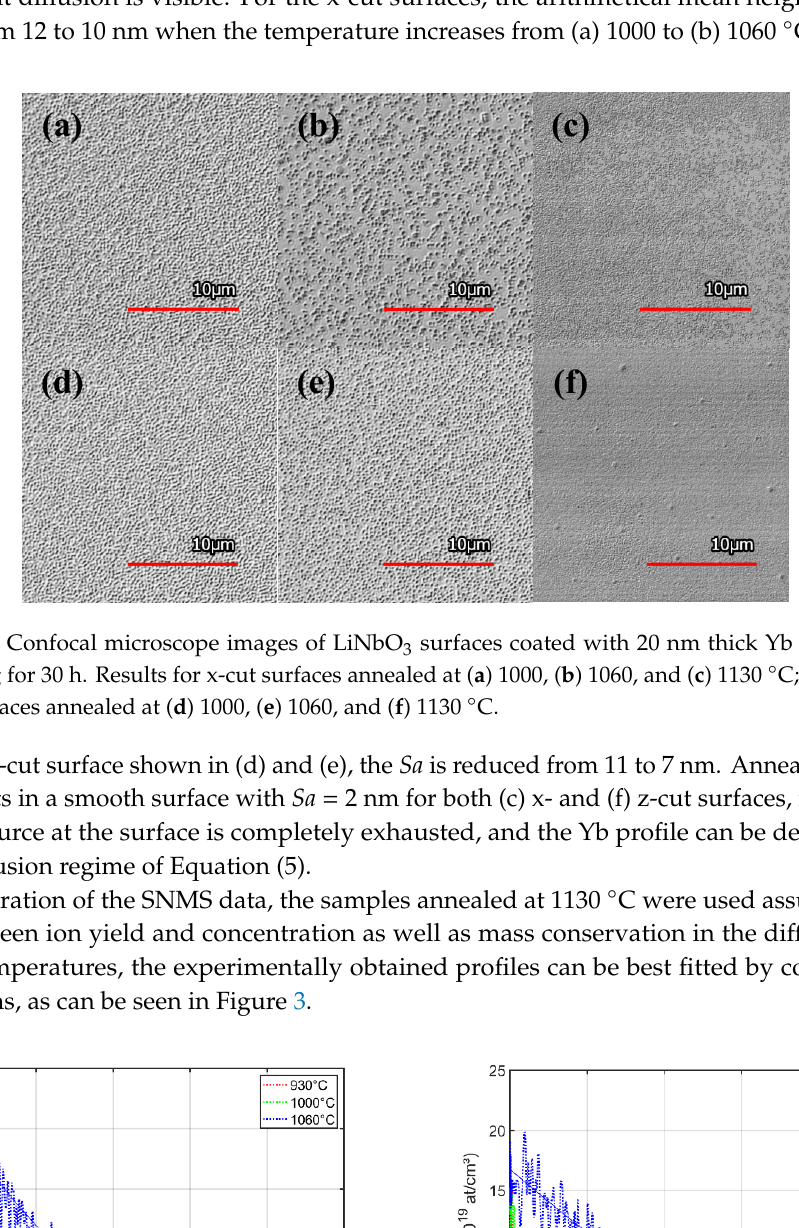
Figure 4. SNMS depth profiles of Yb in LiNbO 3 for in-diffused layers with an initial thickness of 20 nm annealed for 30 h at 1130 °C for different cut directions. Table 1. Parameters obtained for the Yb diffusion in LiNbO 3 . Temperature (°C)